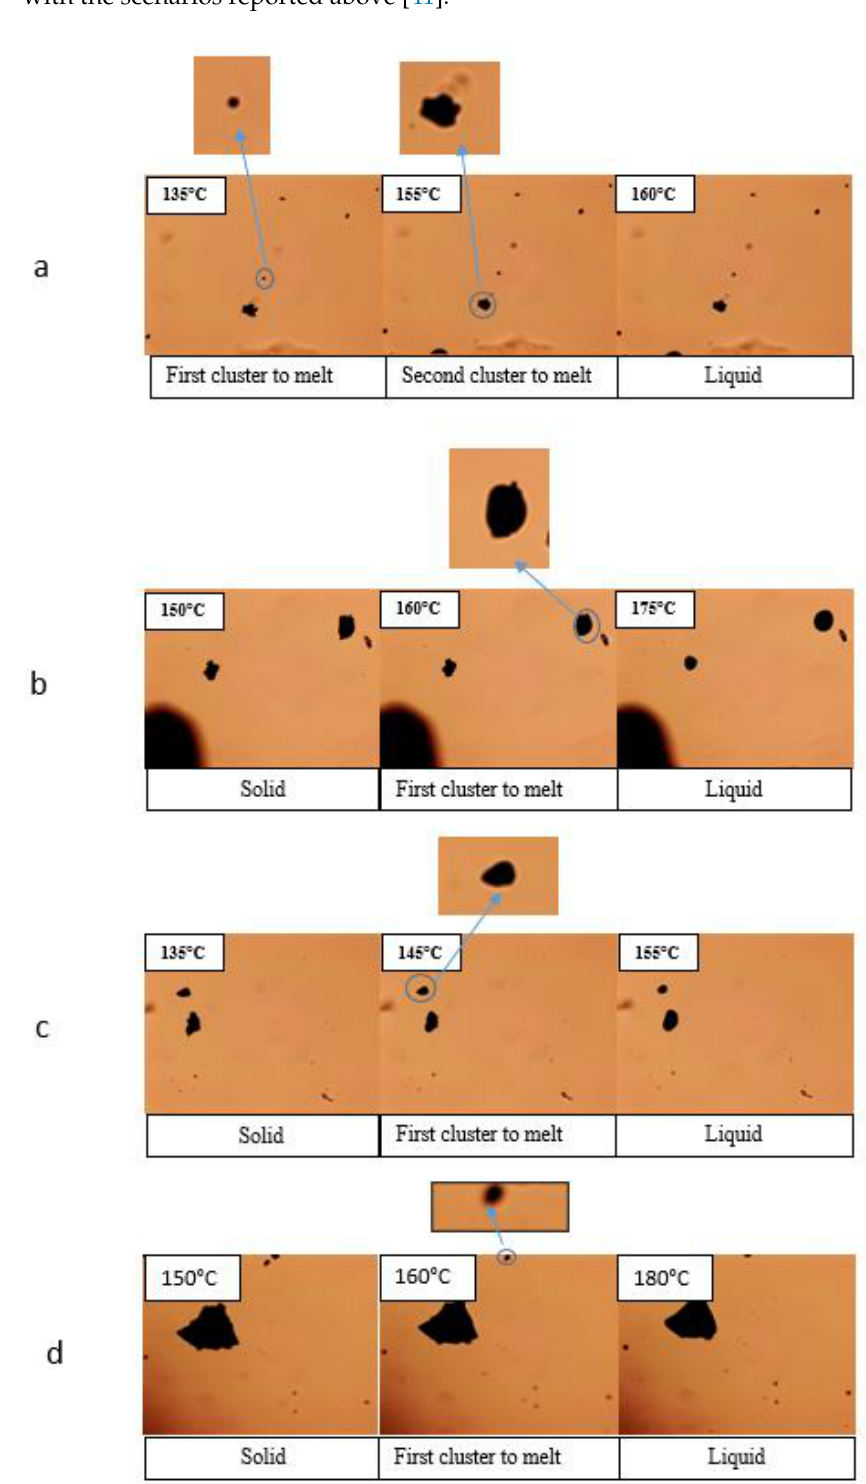
Figure 2. ( a ) Melting points of asphaltenes of non-aged bitumen; ( b ) Melting points of PAV; ( c ) Melting points of PAV + Agent 3; ( d ) Melting points of PAV + Agent 4.